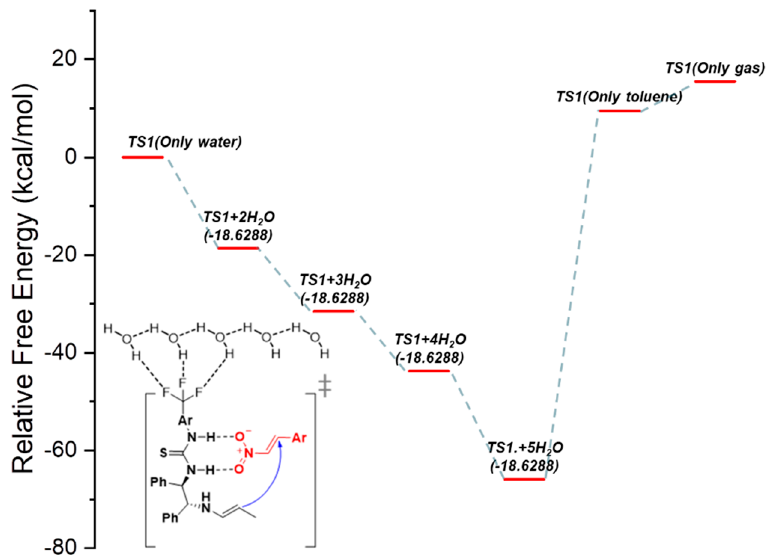
Figure 5. Proposed catalytic mechanism based on the B3LYP/6-31G(d,p) method. Here, the calculations were performed using water, toluene, and solvent + H 2 O conditions. The relative free energy diagram of the ( R , R )-1,2-diphenylethylen-ediamine(DPEN)-thiourea catalyzed enantioselective Michael reaction.